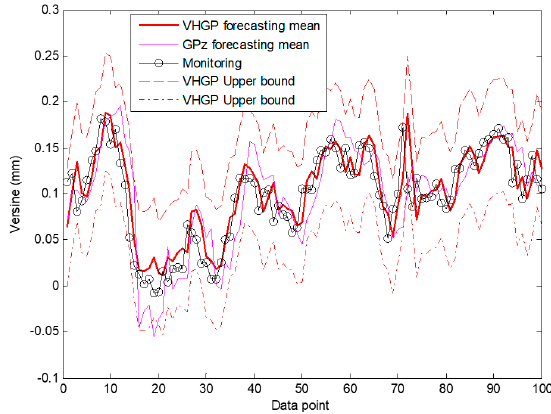
Figure 13. GPz and VHGP forecasting results for S18.